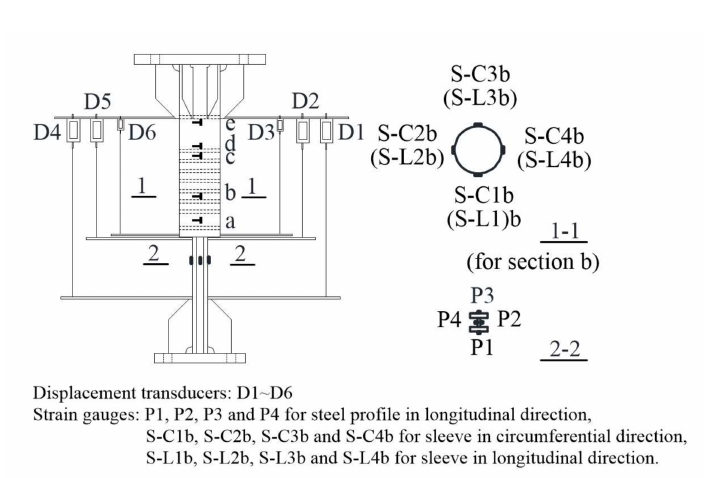
Figure 6. Arrangement of displacement transducers and strain gauges for Specimen RT350.